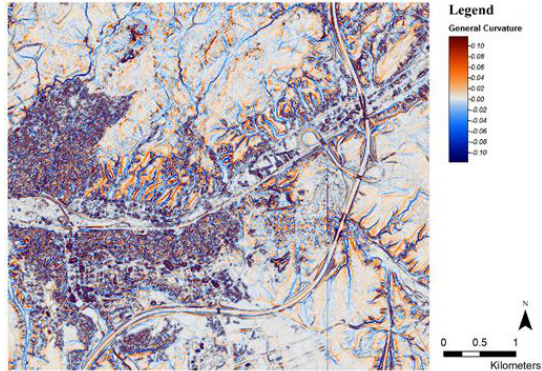
Figure 6. General curvature map of the study area.